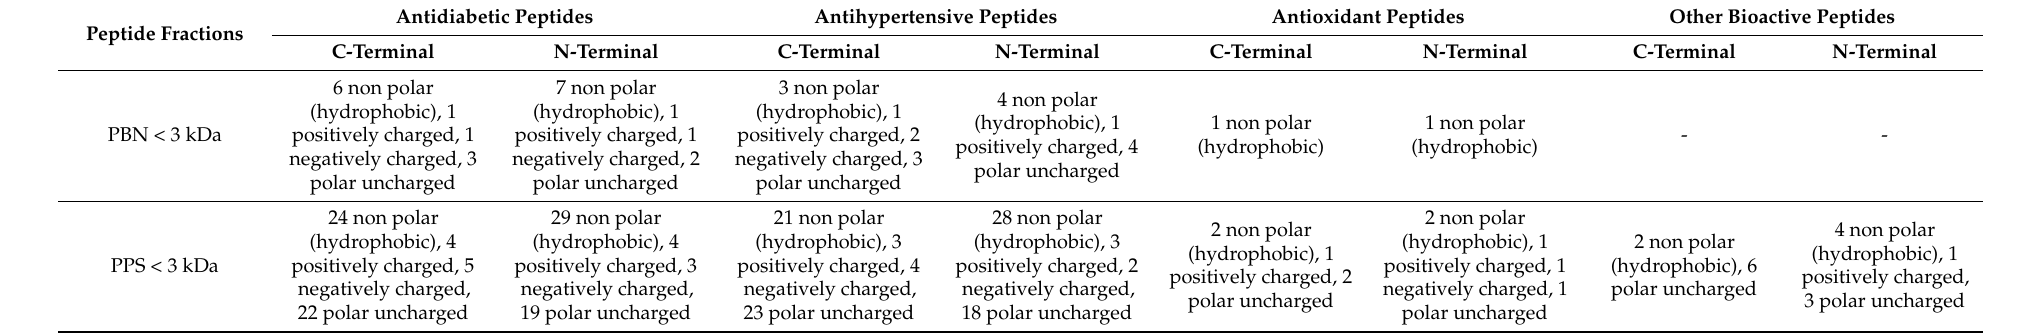
Table 7. Number of bioactive peptides characterized by amino acid residues at C-terminal and N-terminal present in the PBN and PPS fractions <3